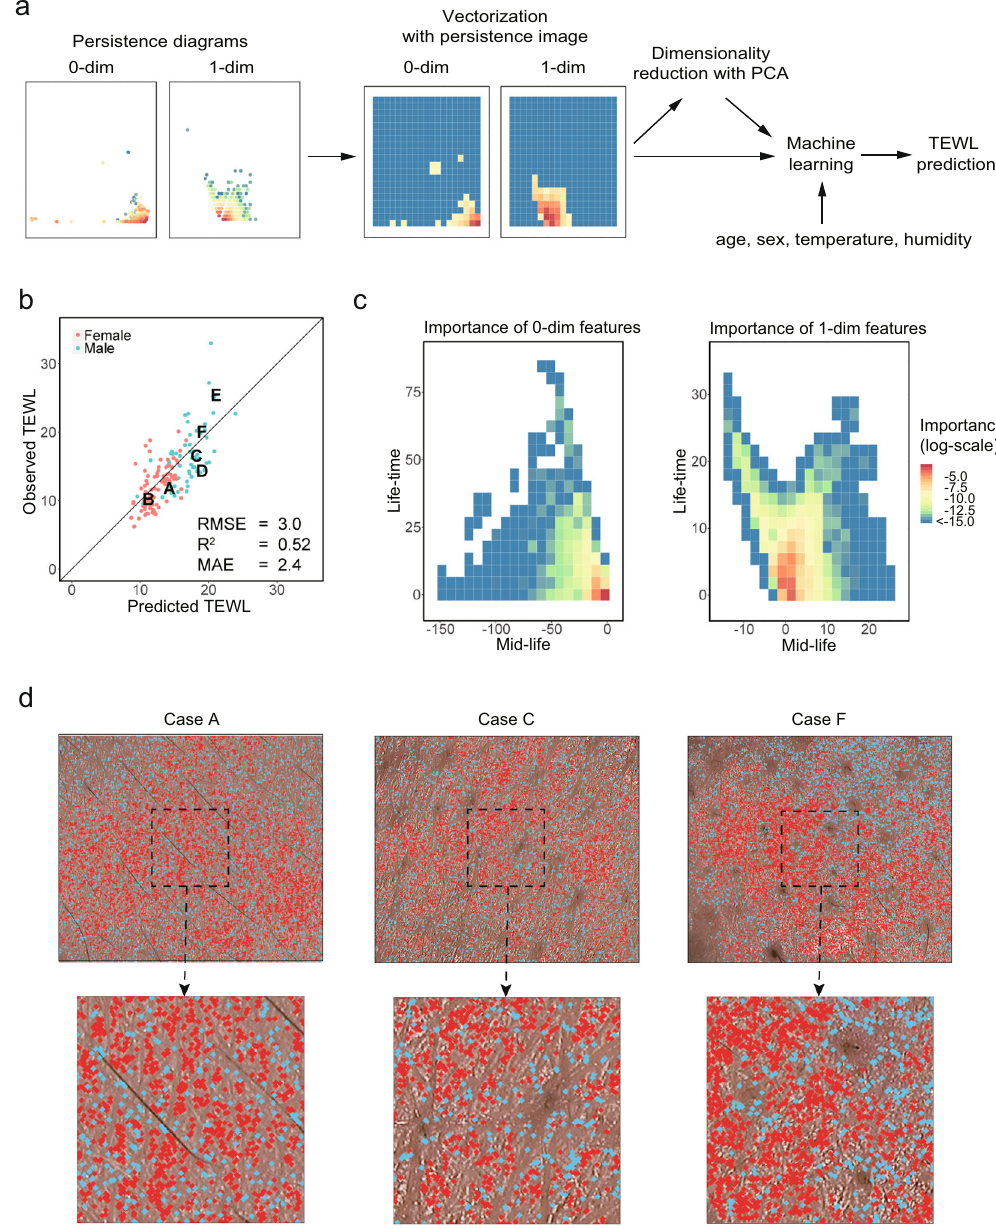
Fig. 3 Prediction of TEWL. a The protocol for TEWL prediction using machine learning. Each persistence diagram was vectorized by the persistence image. Then, when using principal component analysis (PCA), each vector was reduced to a low-dimensional vector with PCA and combined with age, sex, temperature, and humidity to create a feature vector. Using the feature vectors, several machine-learning analyses were performed to predict TEWL. b Predicted vs. observed plots of TEWL produced by random forest regression. The values of cases A – F in Fig. 2a are also labeled. As indicators of accuracy, the coef fi cient of determination ( R 2 ), the root mean squared error (RMSE), and the mean absolute error (MAE) are shown. c The variable importance of each region in the persistence diagrams is calculated by the random forest regression model according to how much the variable contributed to the regression of TEWL. d For cases A, C, and F in Fig. 2a, the birth position of connected components (red) and the death position of holes (blue) in the most important regions of the persistence diagrams are drawn (upper row) and enlarged (lower extrapolated to dermatological disease research for precision medicine. More samples may be needed to re fl ect the diversity of the patients; in addition to phenotypes, genetic factors such as FLG mutations should also be analyzed to improve understanding of the disease pathology. Deep clinical phenotyping based on TDA can provide a basis for precision medicine in dermatology by quantifying clinical characteristics and associating them with molecular biological knowledge.